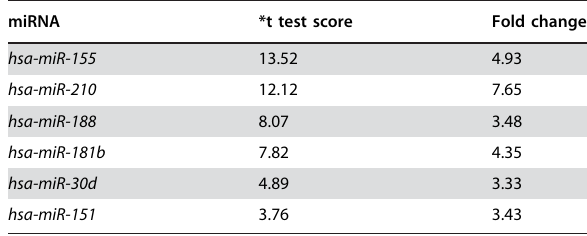
Table 2. microRNAs up-regulated in DFOM-induced CNE. .. ... .... ... ... .... ... ... .... ... ... .... ... ... .... ... ... .... ... ... .... . miRNA *t test score Fold change